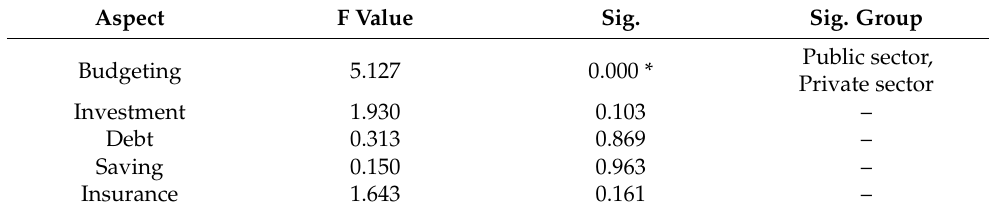
Table 15. Differences according to employment sector using the ANOVA test ( n = 887).